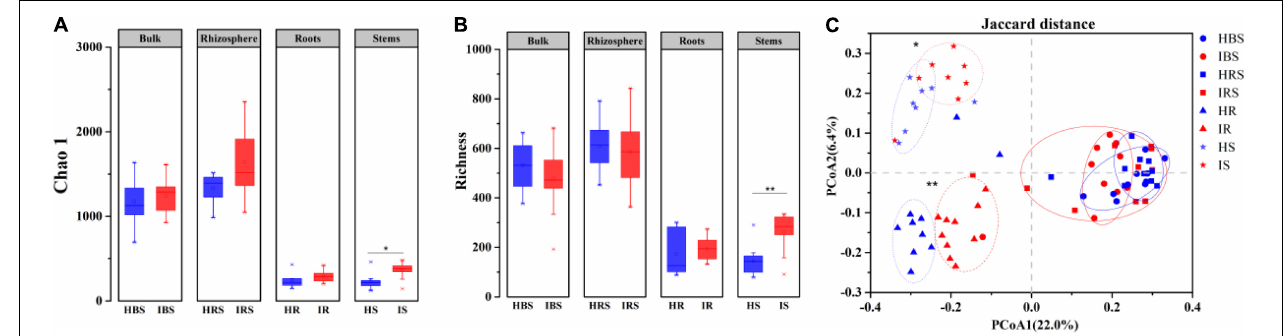
FIGURE 1 | Diversity and structure of fungal communities in the healthy and infected bulk soil, rhizosphere soil, and root and stem endophytic compartments based on internal transcribed spacer (ITS) sequencing. (A) Richness. (B) Chao 1 index. (C) PCoA plot of fungal communities in healthy and infected plants. Note: blue and red indicate healthy and infected samples, respectively. HBS: bulk soils samples of healthy tobacco, IBS: bulk soil samples of wilt-infected tobacco, HRS: rhizosphere samples of healthy tobacco, IRS: rhizosphere samples of wilt-infected tobacco, HR: root samples of healthy tobacco, IR: root samples of wilt-infected tobacco, HS: stem samples of healthy tobacco, IS: stem samples of wilt-infected tobacco. Wilcoxon test and PERMANOVA were used to examine the statistical significance of differences for alpha and beta diversity, respectively. Difference was significant at *, 0.05; **,